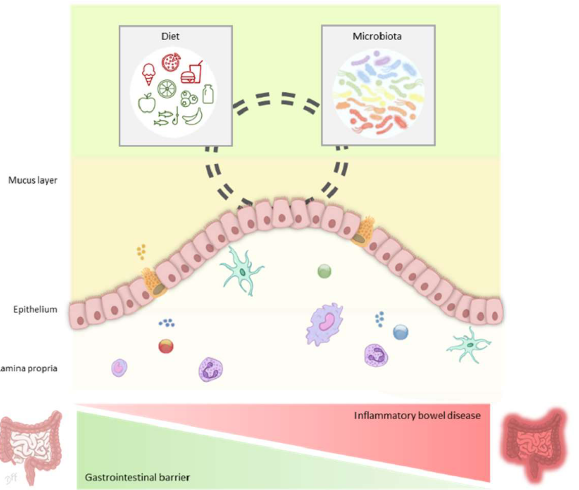
Figure 1. Diet and the gut microbiota regulate gastrointestinal barrier in healthy gut and inflammatory bowel disease. Schematic representation of the influence of diet that may act directly on components of the gastrointestinal barrier and indirectly through shaping microbiota composition, function and its energy source. Some dietary compounds usually found in Mediterranean diet (green) may favor the gastrointestinal barrier, as opposed to the factors of Western-style diet (red). The impact of host-microbiota interactions at the gut lumen and mucus layer, epithelium and mucosal immune system is essential to balance the gastrointestinal barrier in contrast to the alterations underlying inflammatory bowel disease. Indeed, in general terms, the studies summarized in the present review suggest that some microbiota/diet interactions play a role in maintaining gut homeostasis and mucus function. However, current research on these topics presents several limitations and some questions remain open, especially regarding the deficiencies in the design of robust clinical trials and long-term, evidence-based studies to implement findings in practice. Considering the multifactorial nature of IBD and the lack of effective therapies to cure the disease, improving our understanding on the regulation of the intestinal mucus barrier should be further considered with the goal of providing help in IBD management. Author Contributions: Conceptualization: S.F.T.; Writing—original draft preparation: S.F.-T., L.O.M.; Writing—review and editing: S.F.-T., L.O.M., M.C., J.P.G. All authors have read and agreed to the published version of the manuscript. Funding: S.F.T. was funded by the Instituto de Salud Carlos III (Sara Borrell fellowship CD17/00014). L.O.M. is funded by the Community of Madrid and Universidad Autónoma de Madrid (Ayudas Atracción de Talento modalidad 2 BMD-5800). Institutional Review Board Statement: Not applicable. Informed Consent Statement: Not applicable. Data Availability Statement: All data described in the review are included in this published article. Conflicts of Interest: The authors declare that the research was conducted in the absence of any commercial or financial relationships that could be construed as a potential conflict of interest. Abbreviations IBD: inflammatory bowel disease; UC: ulcerative colitis; CD: Crohn´s disease; TNF: tumor necrosis factor; IL: interleukin; IEC: intestinal epithelial cells; PTS: proline, threonine and serine; SCFA: short-chain fatty acids